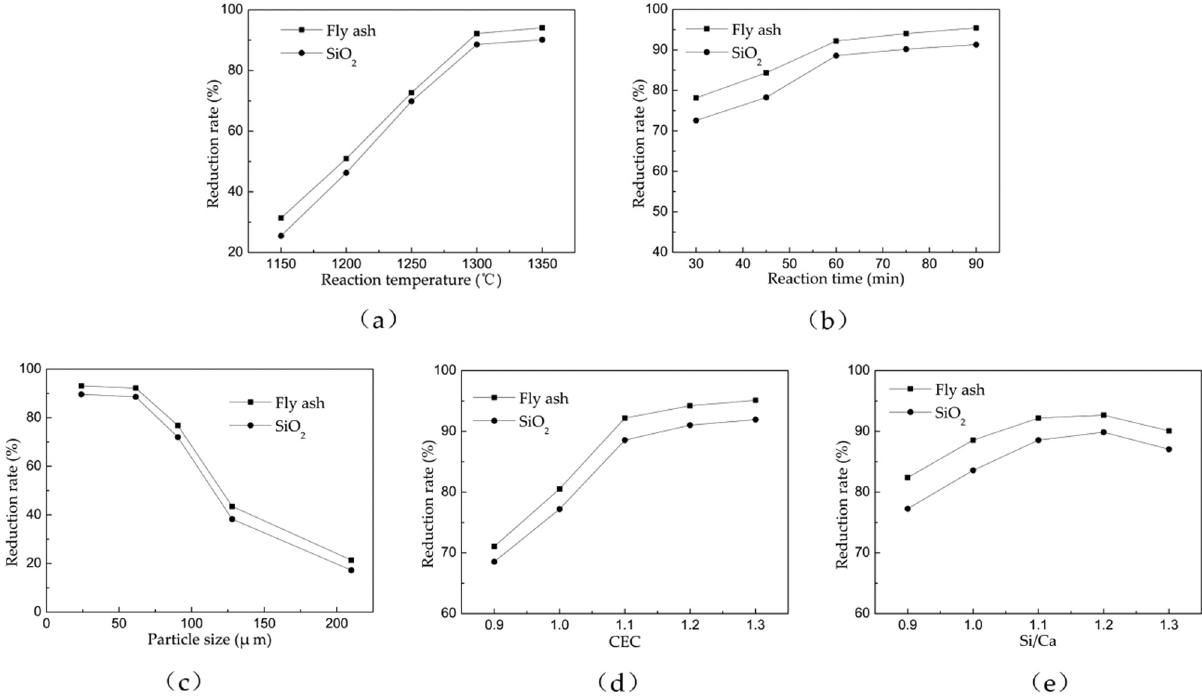
Figure 3: In fl uence of various factors on reduction rate. ( a ) Fixed levels A ( 75 min ) , C ( 48 ∼ 75 µm ) , D ( 1.1 ) , E ( 1.1 ) . ( b ) Fixed levels A ( 1,300°C ) , C ( 48 – 75 µm ) , D ( 1.1 ) , E ( 1.1 ) . ( c ) Fixed levels A ( 1,300°C ) , B ( 75 min ) , D ( 1.1 ) , E ( 1.1 ) . ( d ) Fixed levels A ( 1,300°C ) , B ( 75 min ) , C ( 48 – 75 µm ) , E ( 1.1 ) . ( e ) Fixed levels A ( 1,300°C ) , B ( 75 min ) , C ( 48 – 75 µm ) , D ( 1.1 )